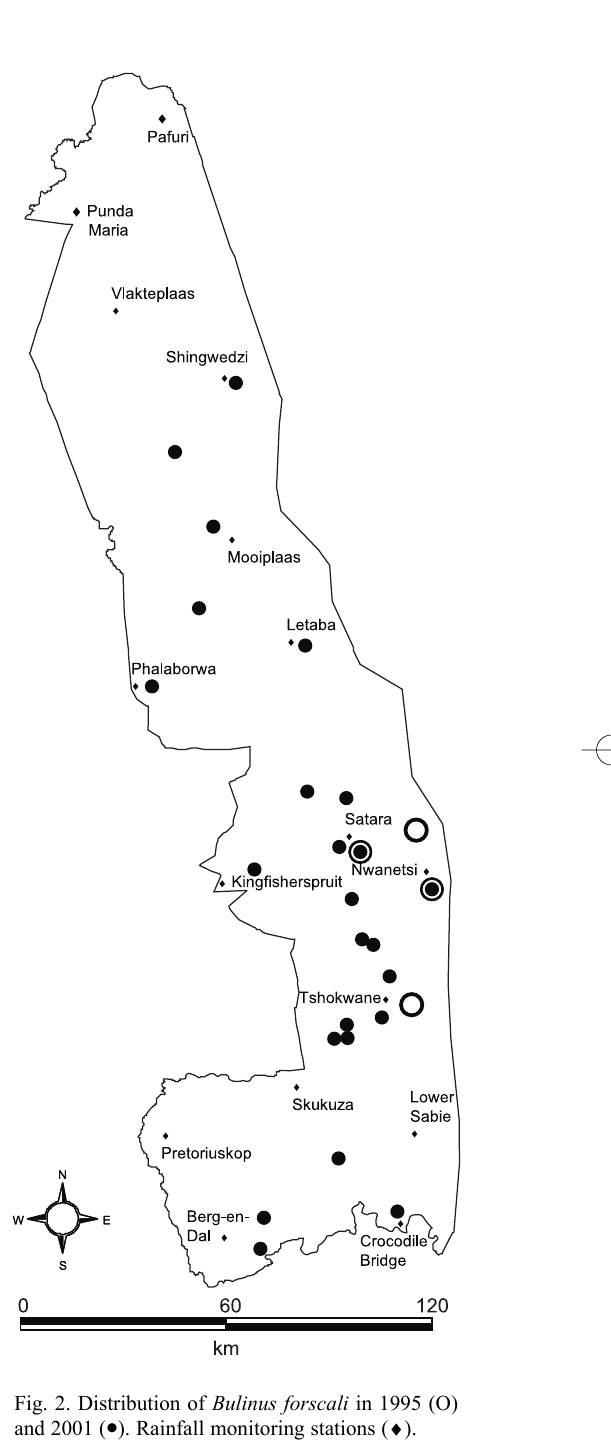
Fig. 2. Distribution of Bulinus forscali in 1995 (O) and 2001 ( • ). Rainfall monitoring stations ( ♦